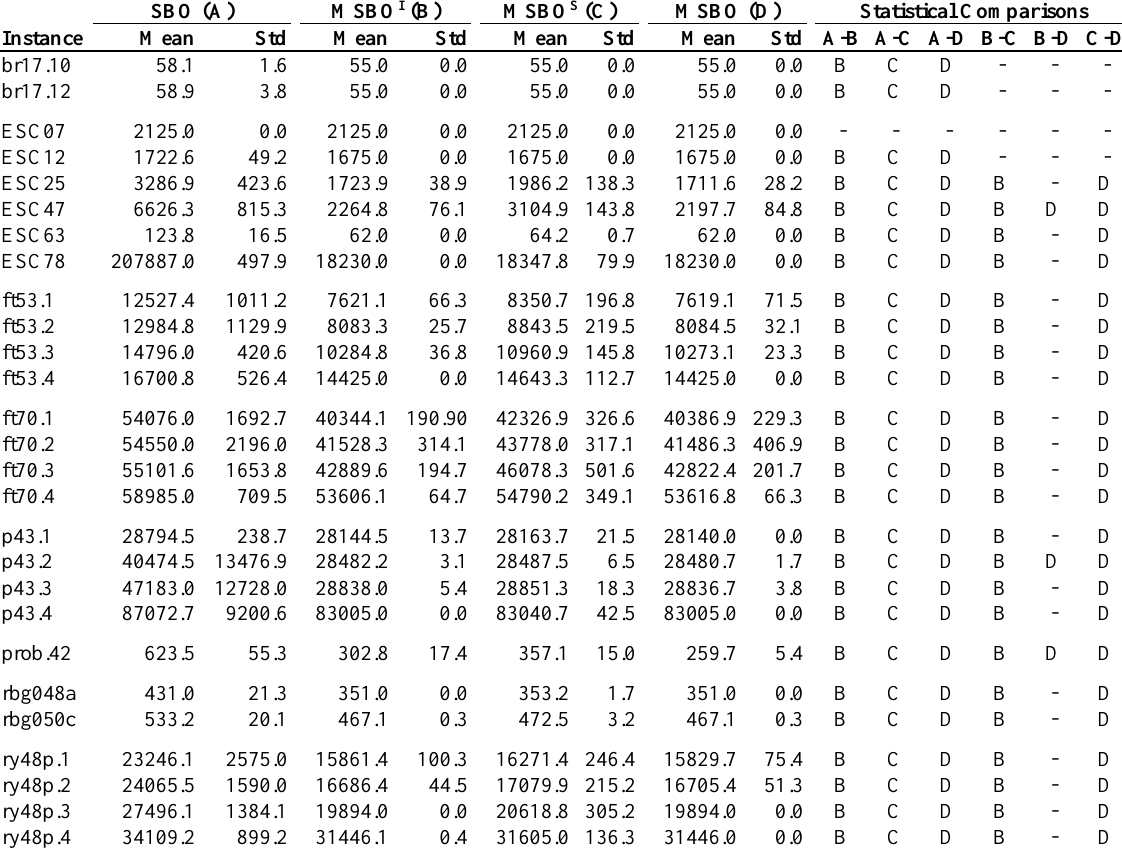
Table 3. Comparisons of SBO and MSBO